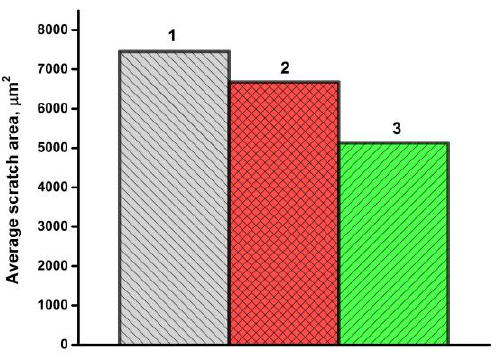
Figure 10. Schematic diagram shows the average scratching area at different arc currents: 1— I Al = 70 A; 2— I Al = 80 A; 3— I Al = 90 A.